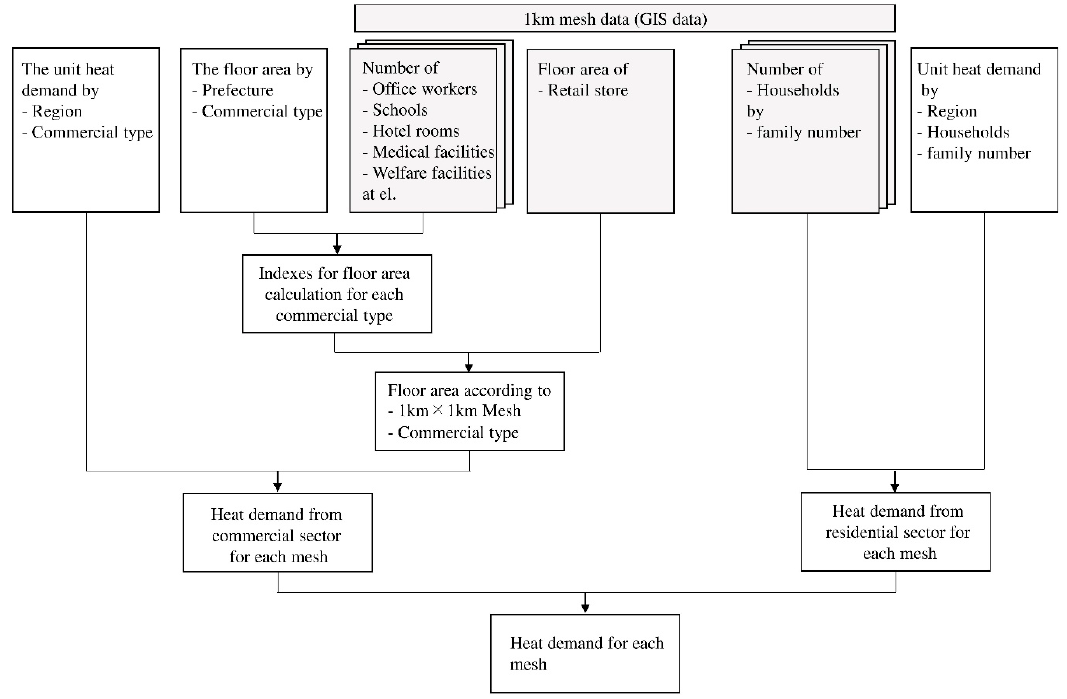
Figure 2. Flowchart of heat demand calculation using a 1 km mesh resolution.